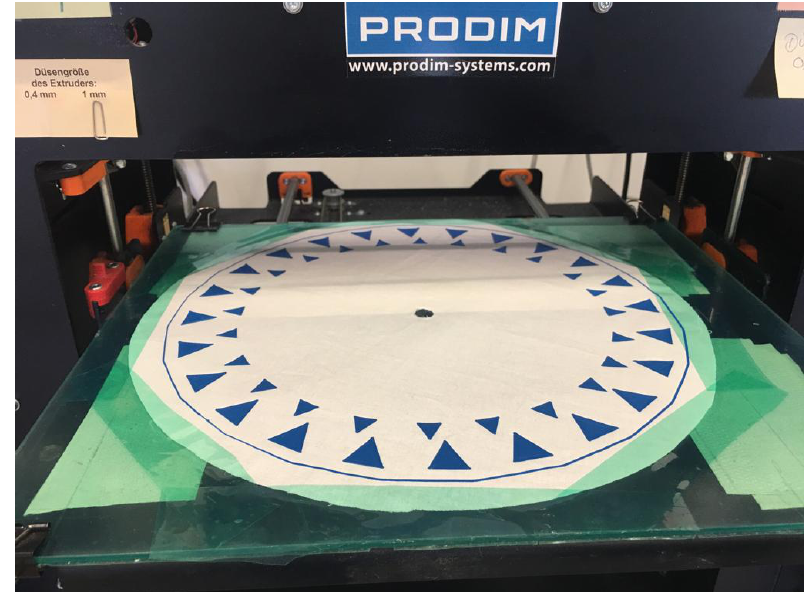
Figure 5. The 3D printing geometry on textile fabric—general view.